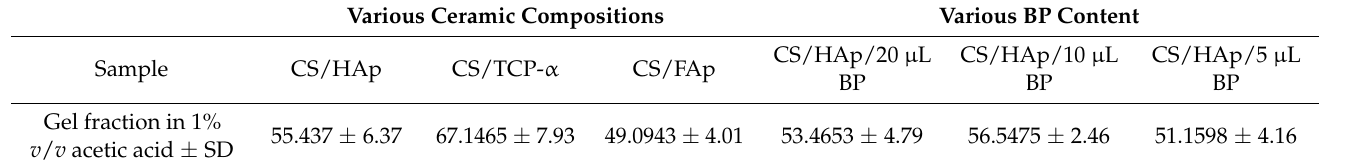
Table 1. Gel fraction values for scaffolds with varied ceramics and BP content in acidic conditions. The higher gel fraction values indicate a better linkage formed.